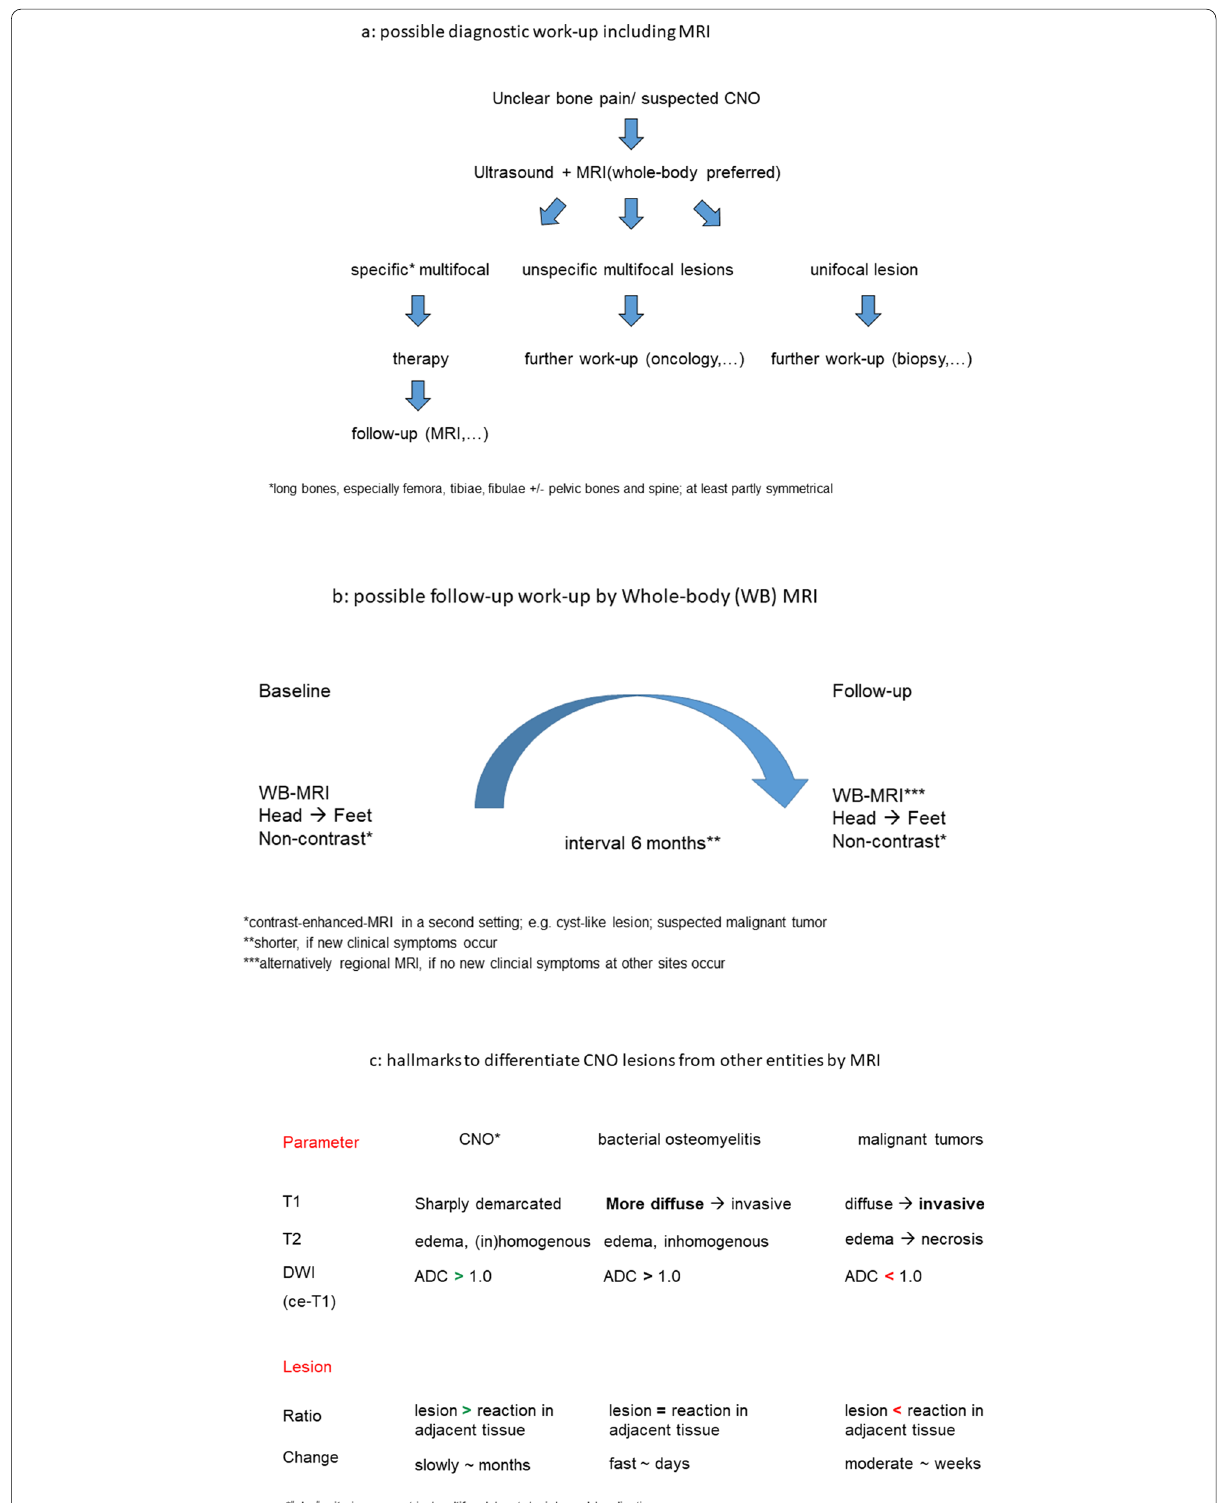
Fig. 7 Flowcharts for diagnostic work-up ( a ), MRI algorithms in primary diagnosis and follow-up ( b ) and imaging hallmarks for differential diagnosis between non-bacterial (CNO), bacterial osteomyelitis and malignant bone lesions ( c